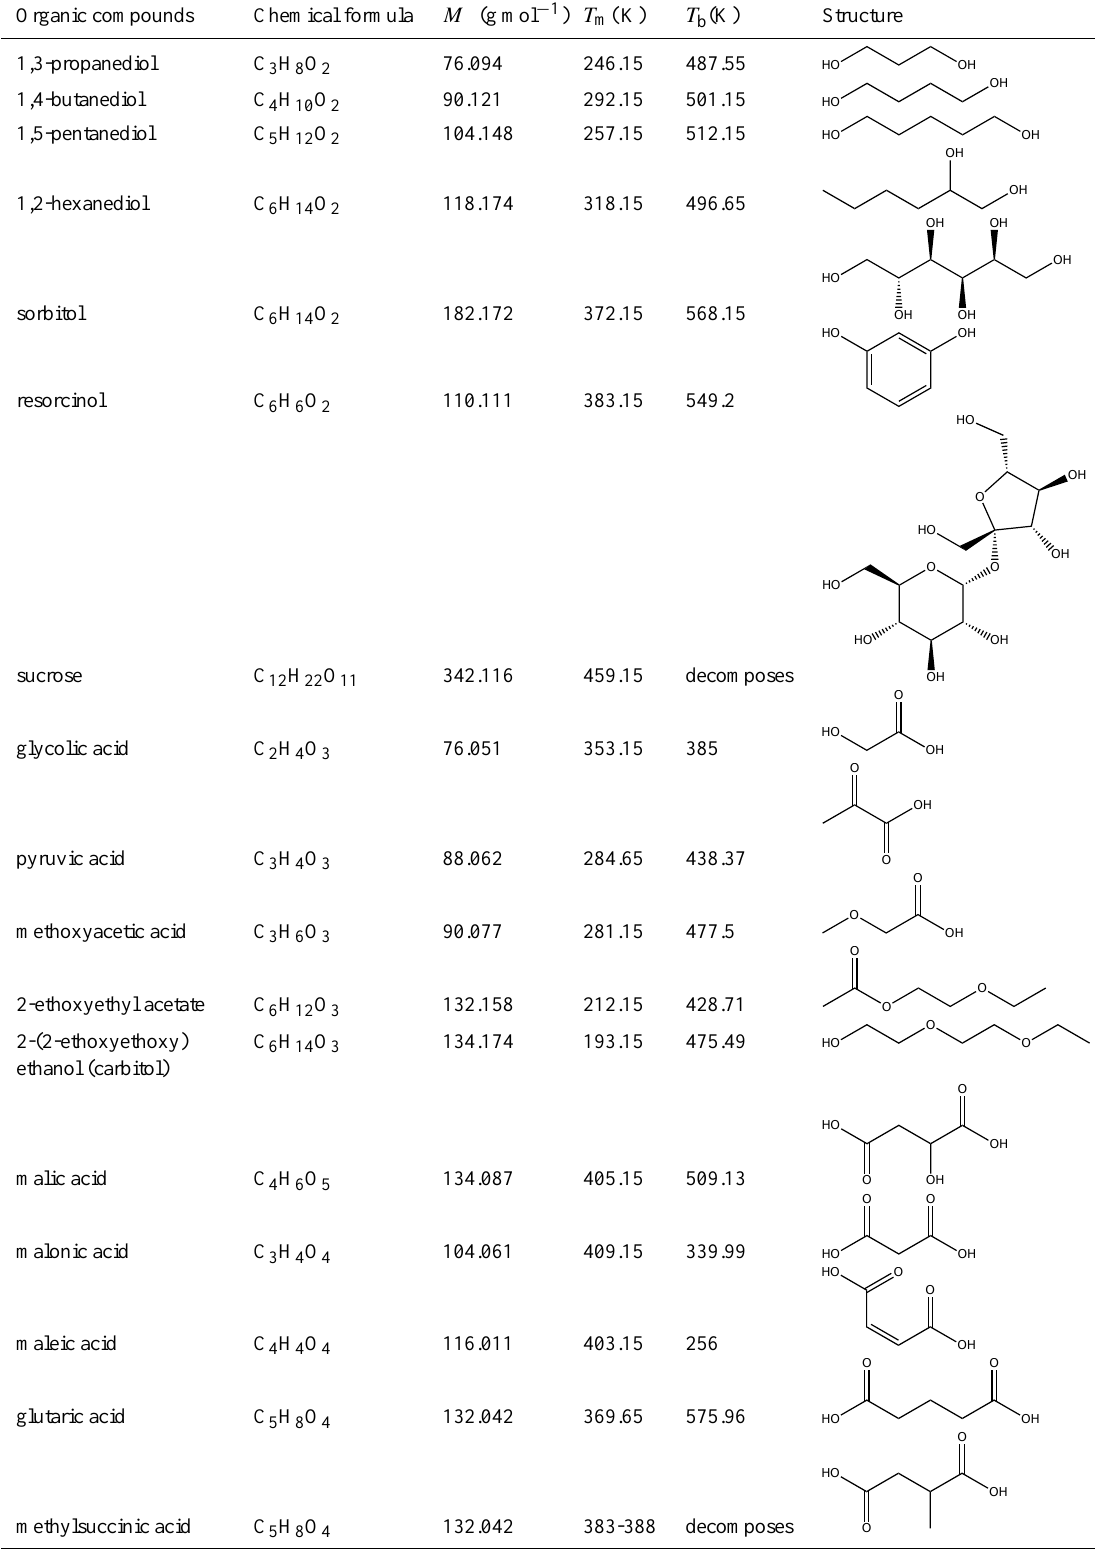
Table 1. Selected physical properties of organic components used for the experiments: molar mass (M) , melting point (T m ) , boiling point (T b ) at standard pressure (101.325kPa), and